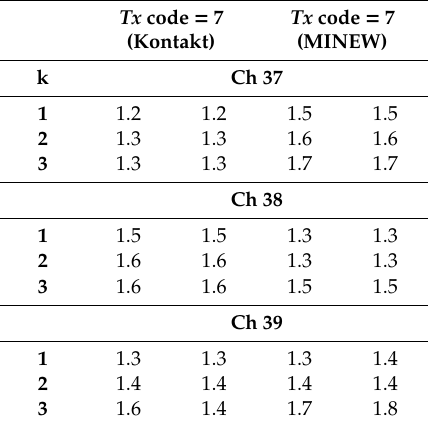
Table 11. Accuracies (in m) for Test #3. For each option, the first and second data columns refer to the iBeacon and Eddystone protocol respectively. The three advertising channels are referred to as Ch 37, etc., and the number of neighbors in the WKNN algorithm, as k .